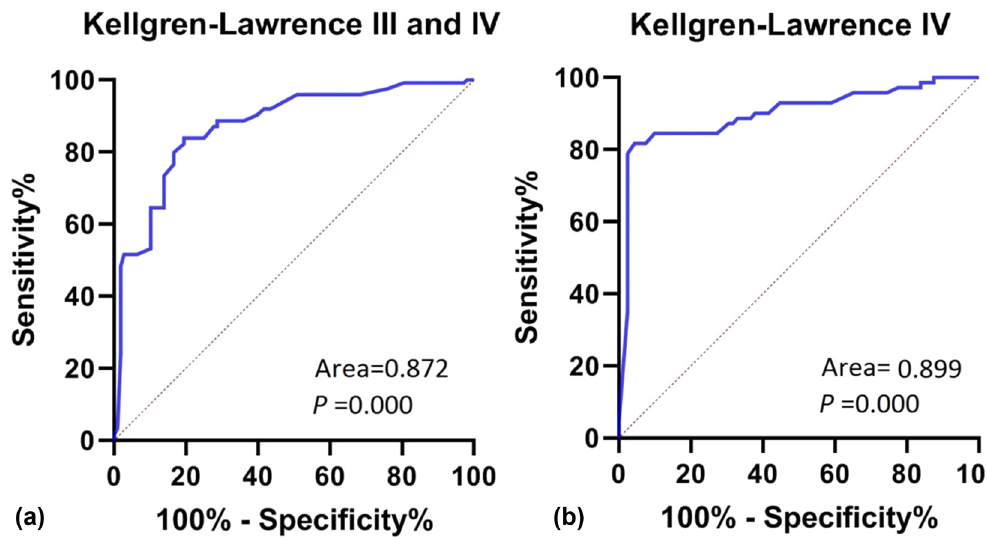
Figure 3: ROC curve analysis, ( a ) K – L grade III and IV and ( b ) K – L grade